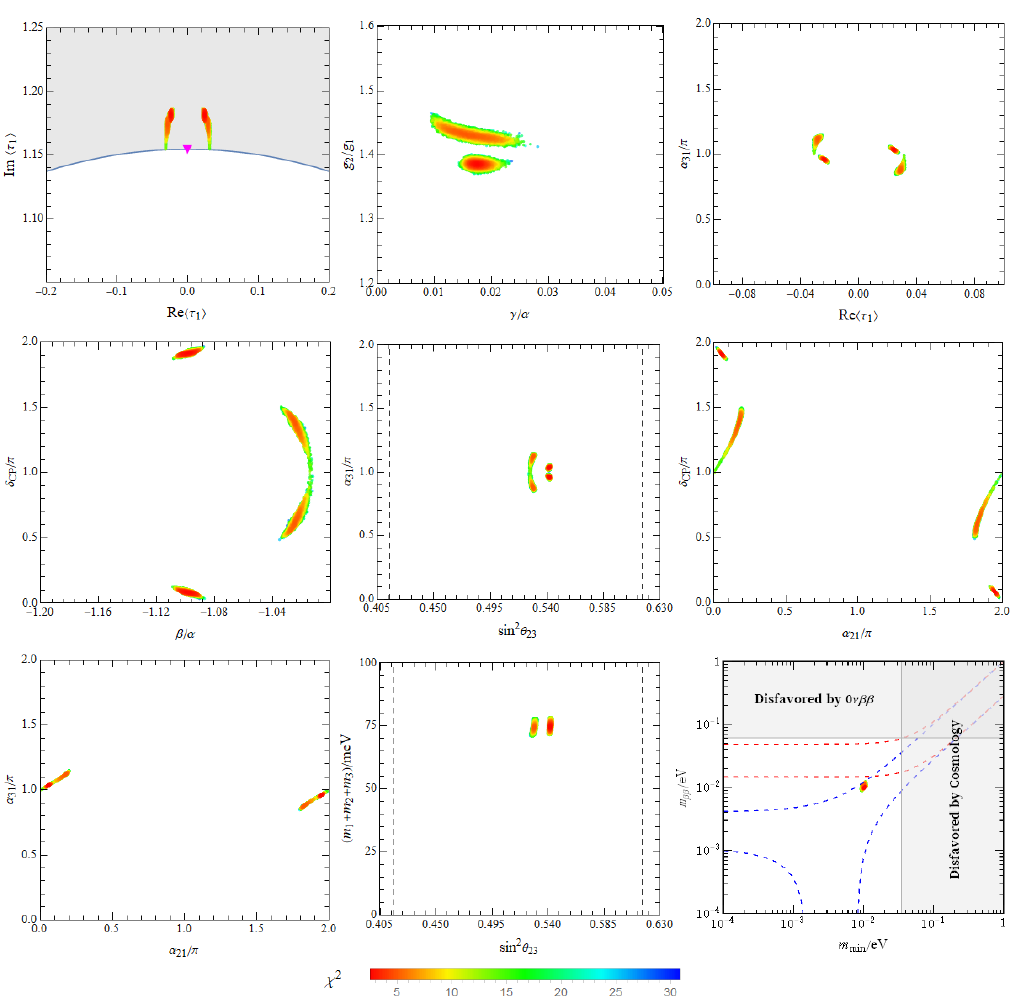
Figure 1: The correlations among the input free parameters, neutrino mixing angles and CP violating phases in the model discussed in the text, where the moduli τ are restricted to the subspace with τ (cid:0) 2 1 (cid:1) τ = i (cid:112) is marked by pink triangle in the τ 1 2 3